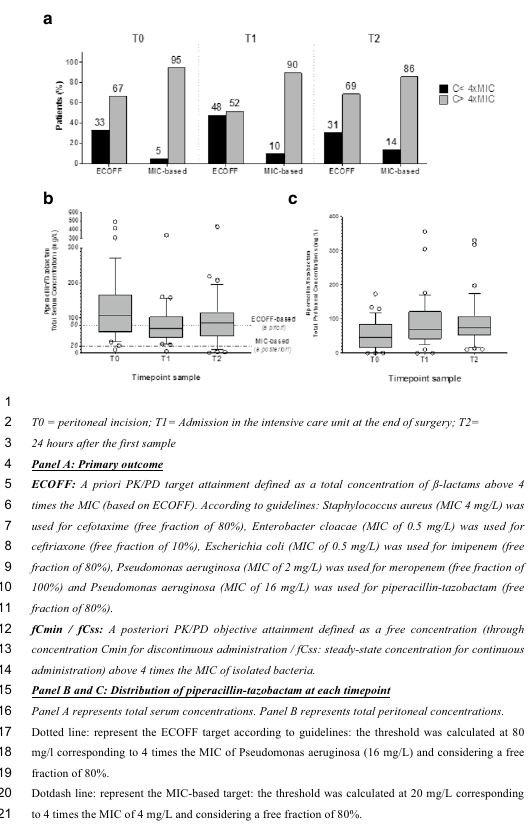
Fig. 1 Serum ß‑lactam PK/PD target attainment and observed total concentrations of Piperacillin‑tazobactam at each